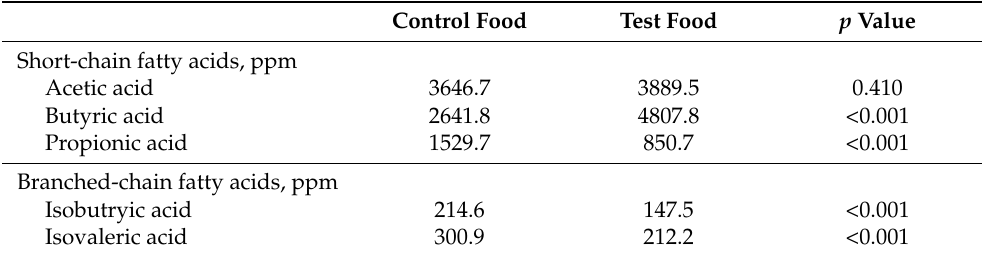
Table 7. Fecal short-chain fatty acids following consumption of the study foods.